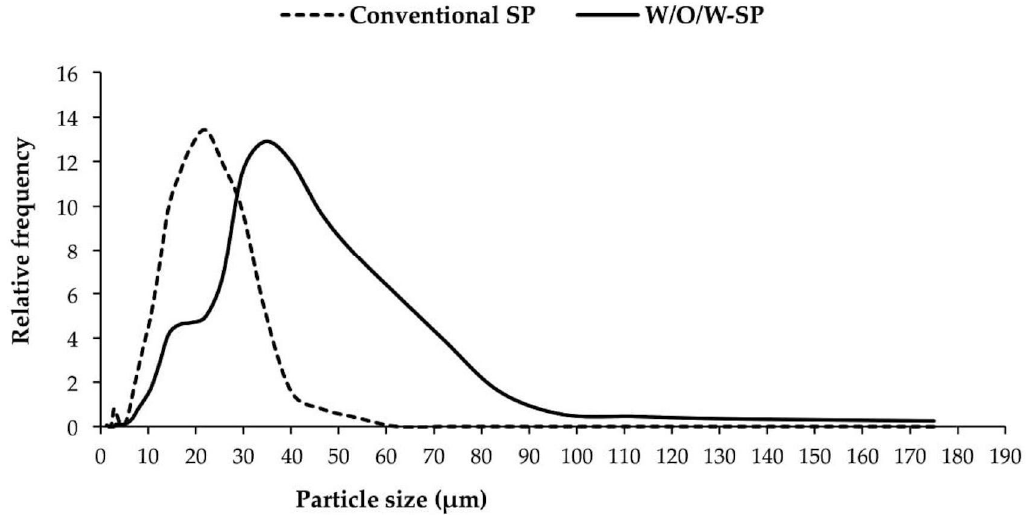
Figure 5. Particle size distribution of powder microcapsules obtained with conventional SP and W/O/W-SP. Drying condition: 160–80 ◦ W/O/W-SP. Drying condition: 160–80 °C.